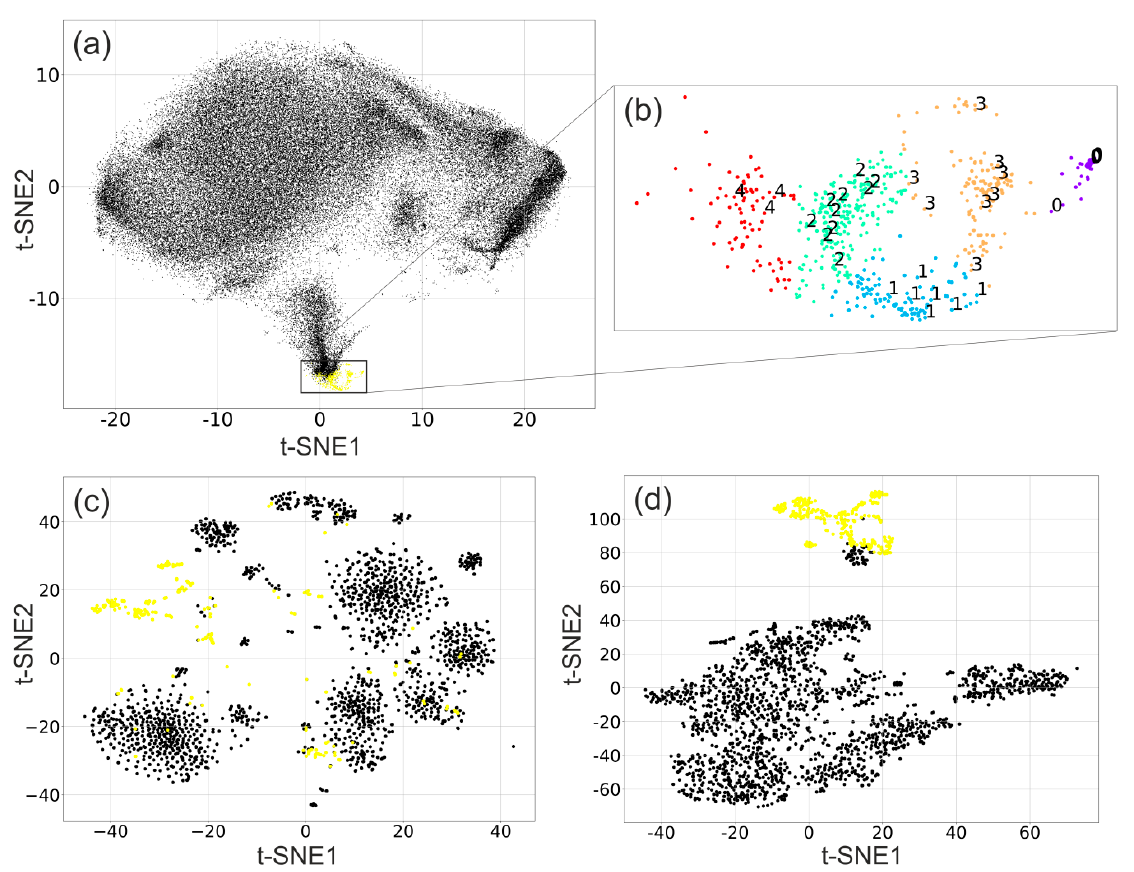
Figure 6. Visualization of the high-dimensional data using t-SNE. ( a ) t-SNE planar representation of the convolutional features extracted from 86,000 attribute maps (combined prediction half-products denoted as AV 1 –AV 6 in Figure 5). The points plotted in yellow correspond to the noise panels classified as event panels. ( b ) K-means clustering of the detected body–wave panels. Each color represents a separate class. ( c ) t-SNE embedding of the initial feature matrix used for training the XGBoost models. The data matrix is comprised of 1900 flattened attribute maps that are not converted to images. ( d ) t-SNE embedding of the deep feature matrix extracted from 1900 images of attribute maps with the CNN-based models. The yellow points in ( c , d ) depict the same manually selected examples of body–wave panels.